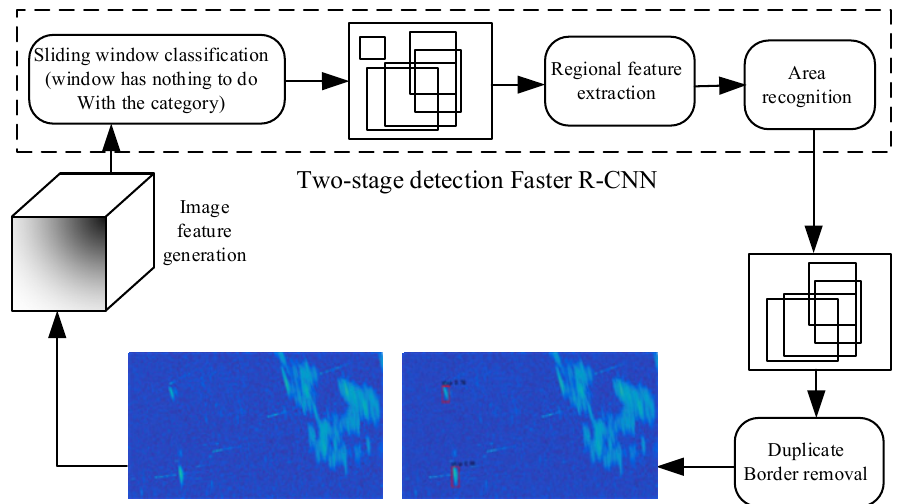
Figure 2. Radar PPI image detection via the two-stage detection algorithm Faster R-CNN.